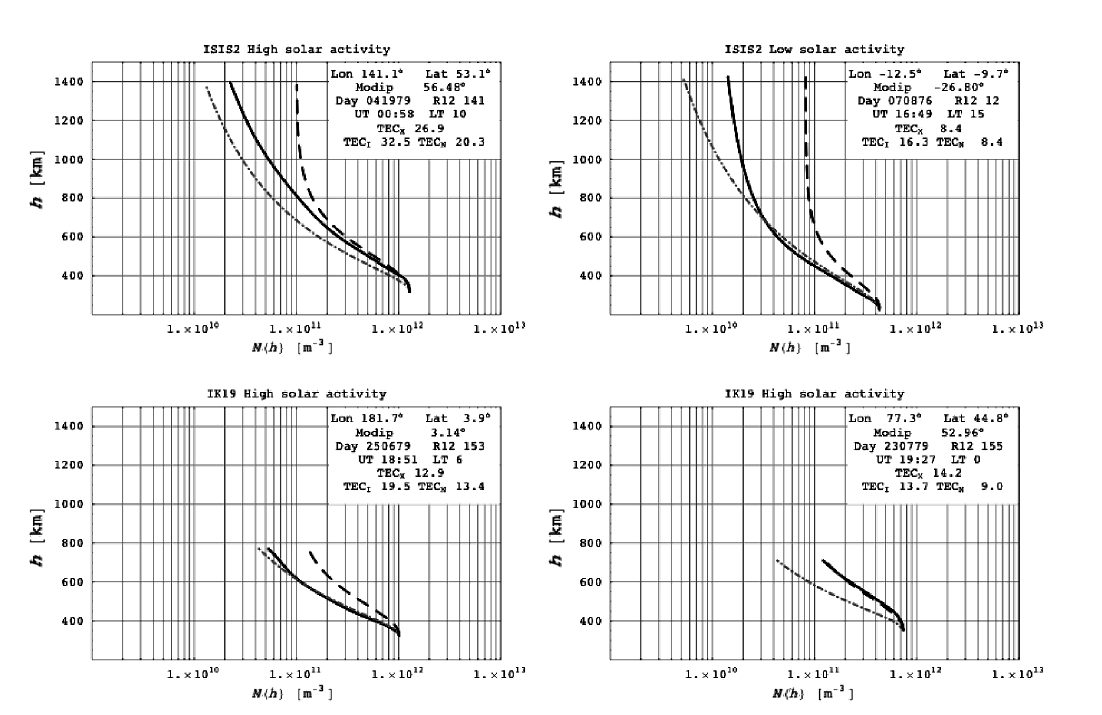
Fig. 18.12. Comparison between experimental profiles from ISIS-2 and IK-19 data and NeQuick and IRI mod- els. Solid line: experimental; dash-dotted line: NeQuick; dashed line: